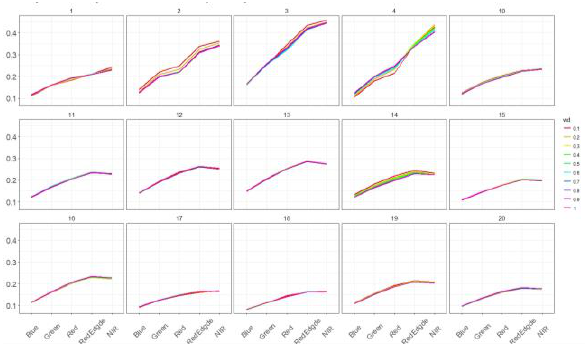
Figure 7. Spectral profiles in the five bands of the RedEdge sensor over the ESU (panels) as a function of the ROI size used for extracting and averaging reflectance.